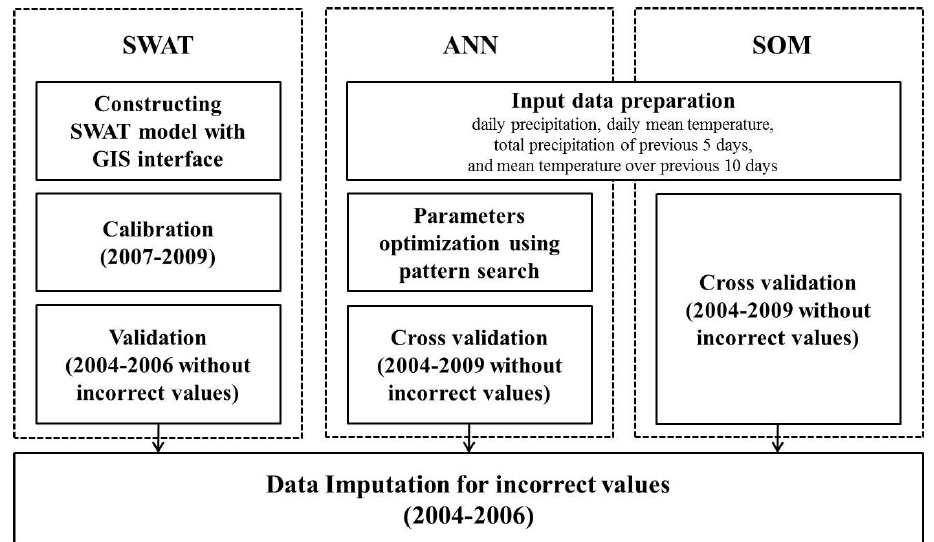
Figure 2. Flow chart of the Data Imputation methodology of the three models: Soil and Water Assessment Tool (SWAT), Artificial Neural Network (ANN), and Self Organizing Map (SOM).